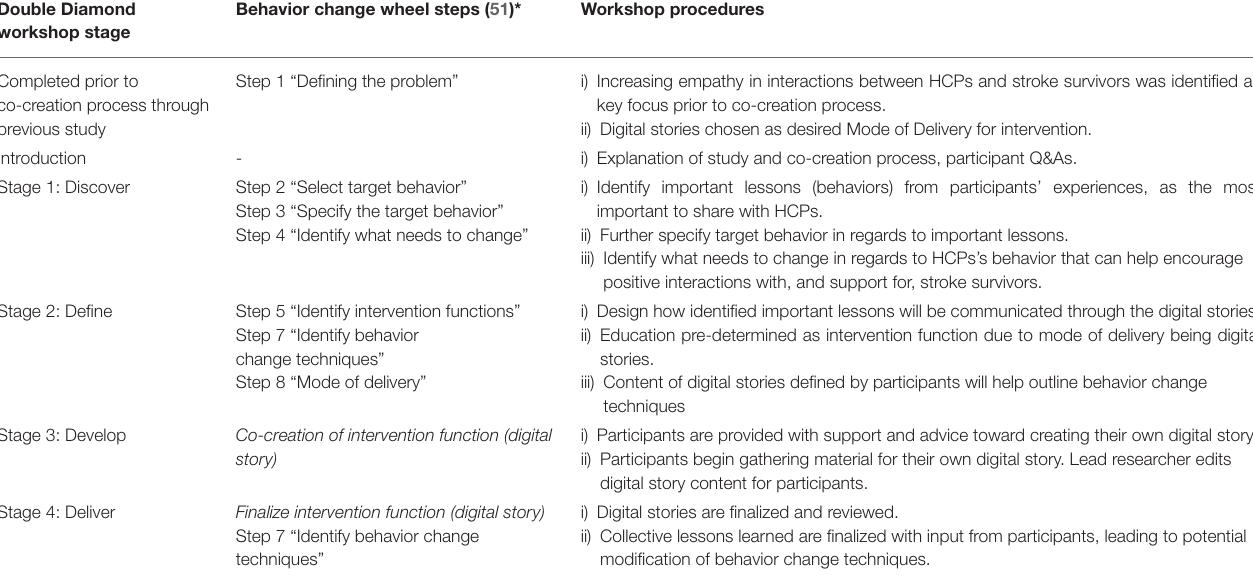
TABLE 1 | Integration of BCW into Double Diamond design